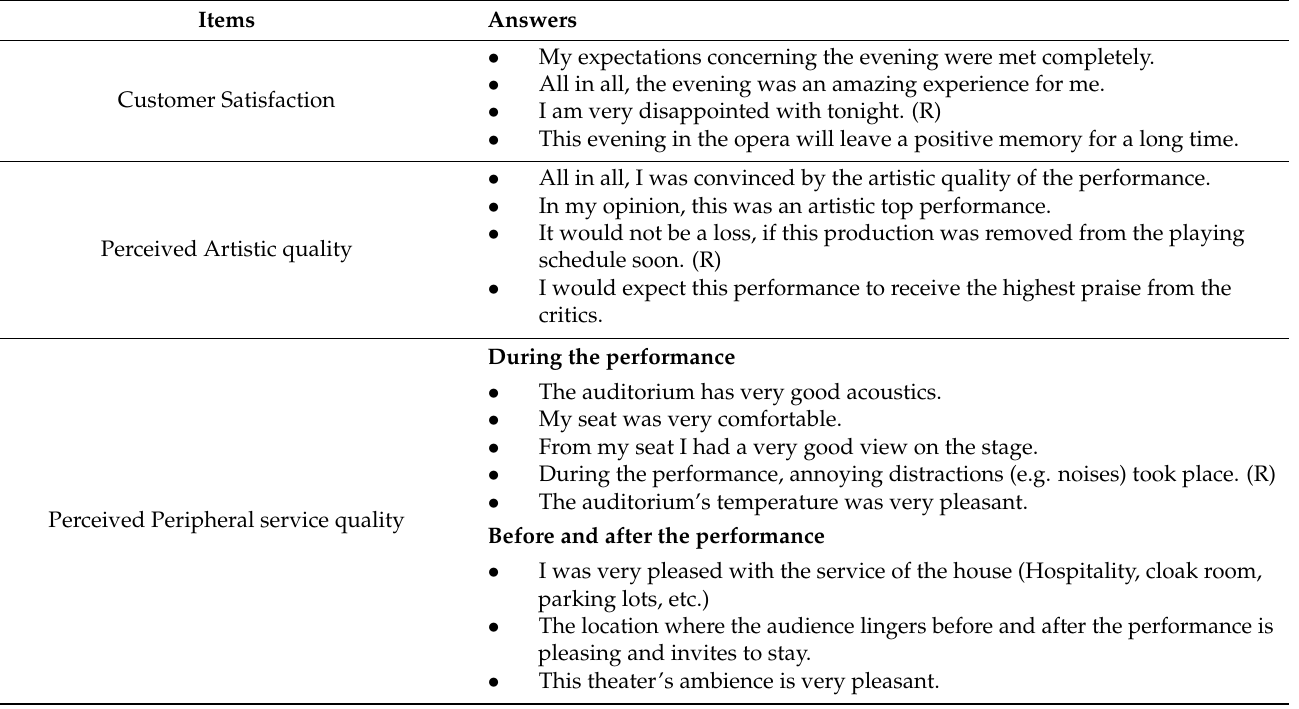
Table 1. Questionnaire for customer satisfaction in opera, adapted from